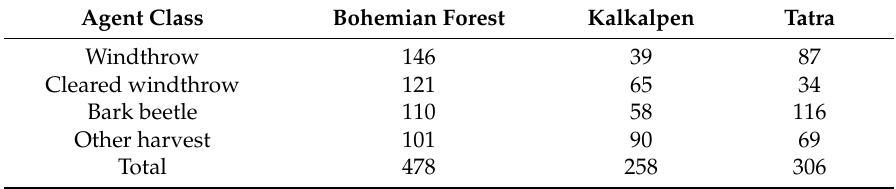
Table 2. Number of polygon samples collected for the disturbance agent classes at the study